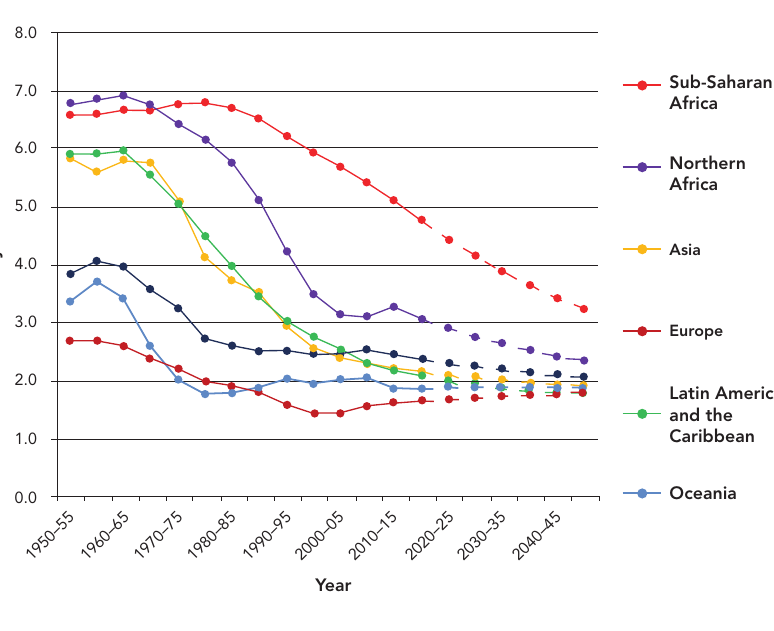
Figure 1: Trend of total fertility rate by world region,